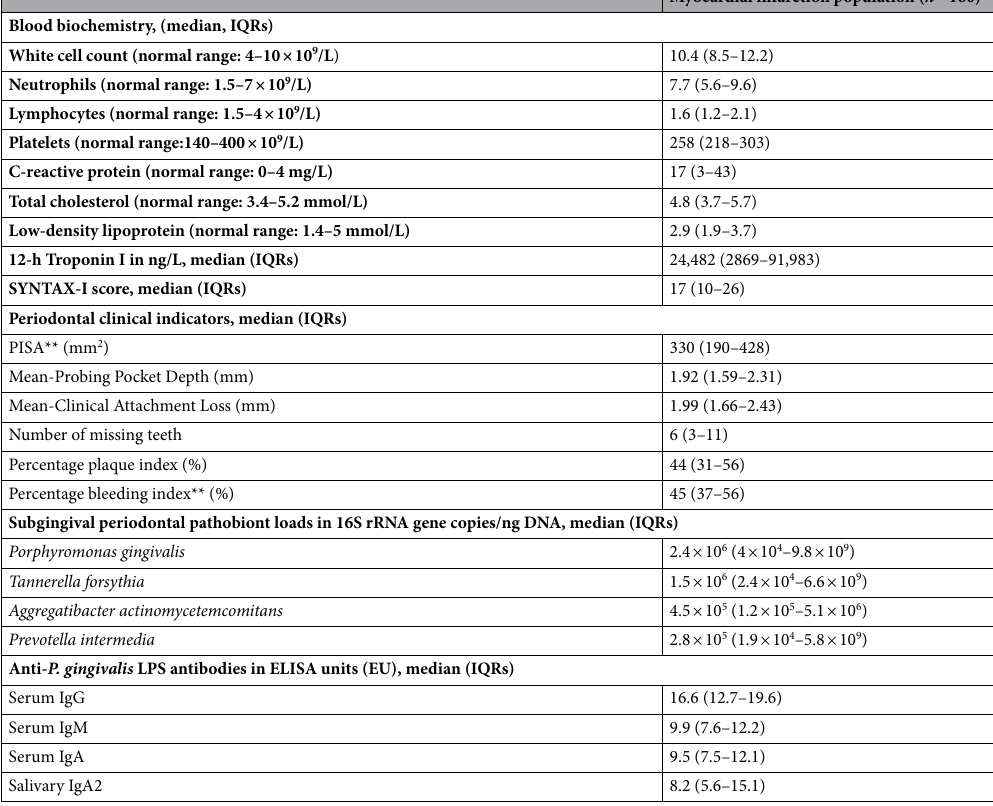
Table 2. Biochemical and microbiological characteristics of the study population. Quantitative measures are expressed as medians and interquartile ranges (IQRs). Periodontitis indicators measured as: site-specific (6 measurements per tooth)—PPD, CAL, BoP; subject-specific- PISA, mean PPD, mean CAL, percentage plaque and bleeding indices. PISA periodontal inflamed surface area, PPD probing pocket depths, CAL clinical attachment loss, SYNTAX The Synergy between percutaneous coronary intervention with TAXUS drug-eluting stent and Cardiac Surgery Score, ELISA The enzyme-linked immunosorbent assay. ** = values of these variables may be influenced by the antiplatelet therapy given in acute myocardial infarction